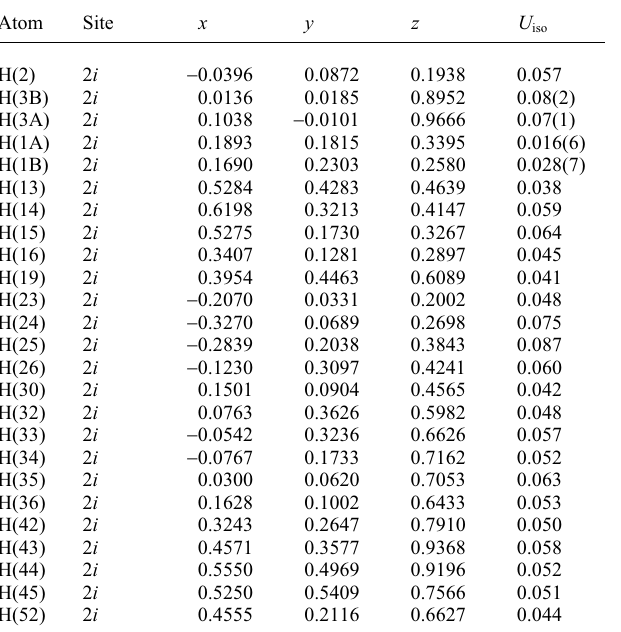
Table 2. Atomic coordinates and displacement parameters (in Å 2 ) .